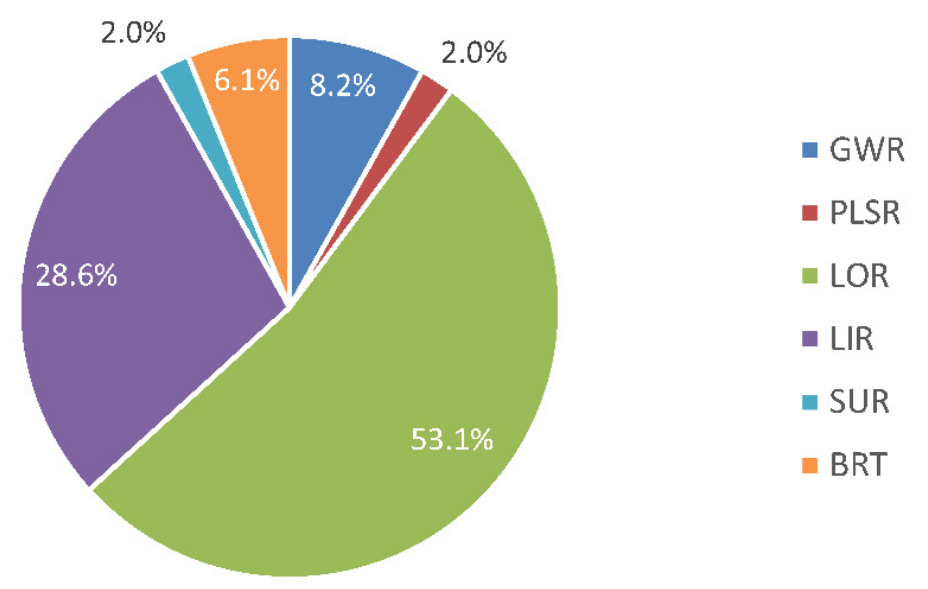
Figure 11. Regression techniques (49 papers). GWR: geographically weighted regression; PLSR: partial least squares regression; LOR: logistic regression; LIR: linear regression; SUR: seemingly unrelated regression; BRT: boosted regression trees. Source: own